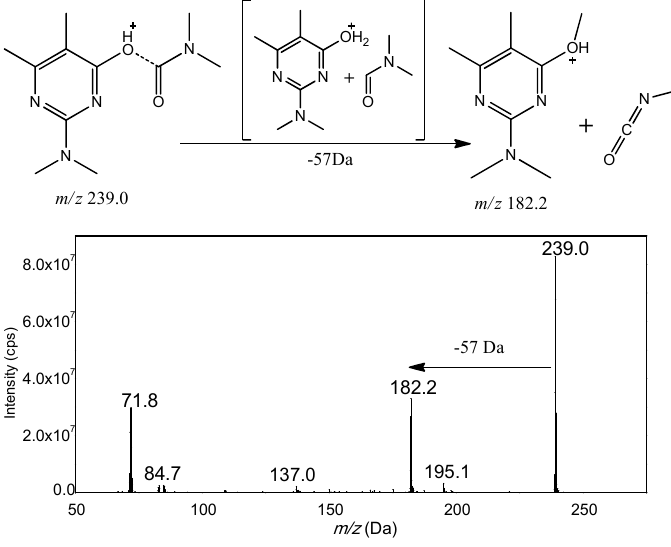
Figure 6. Product ion spectra and probable fragmentation routes of Pirimicarb.